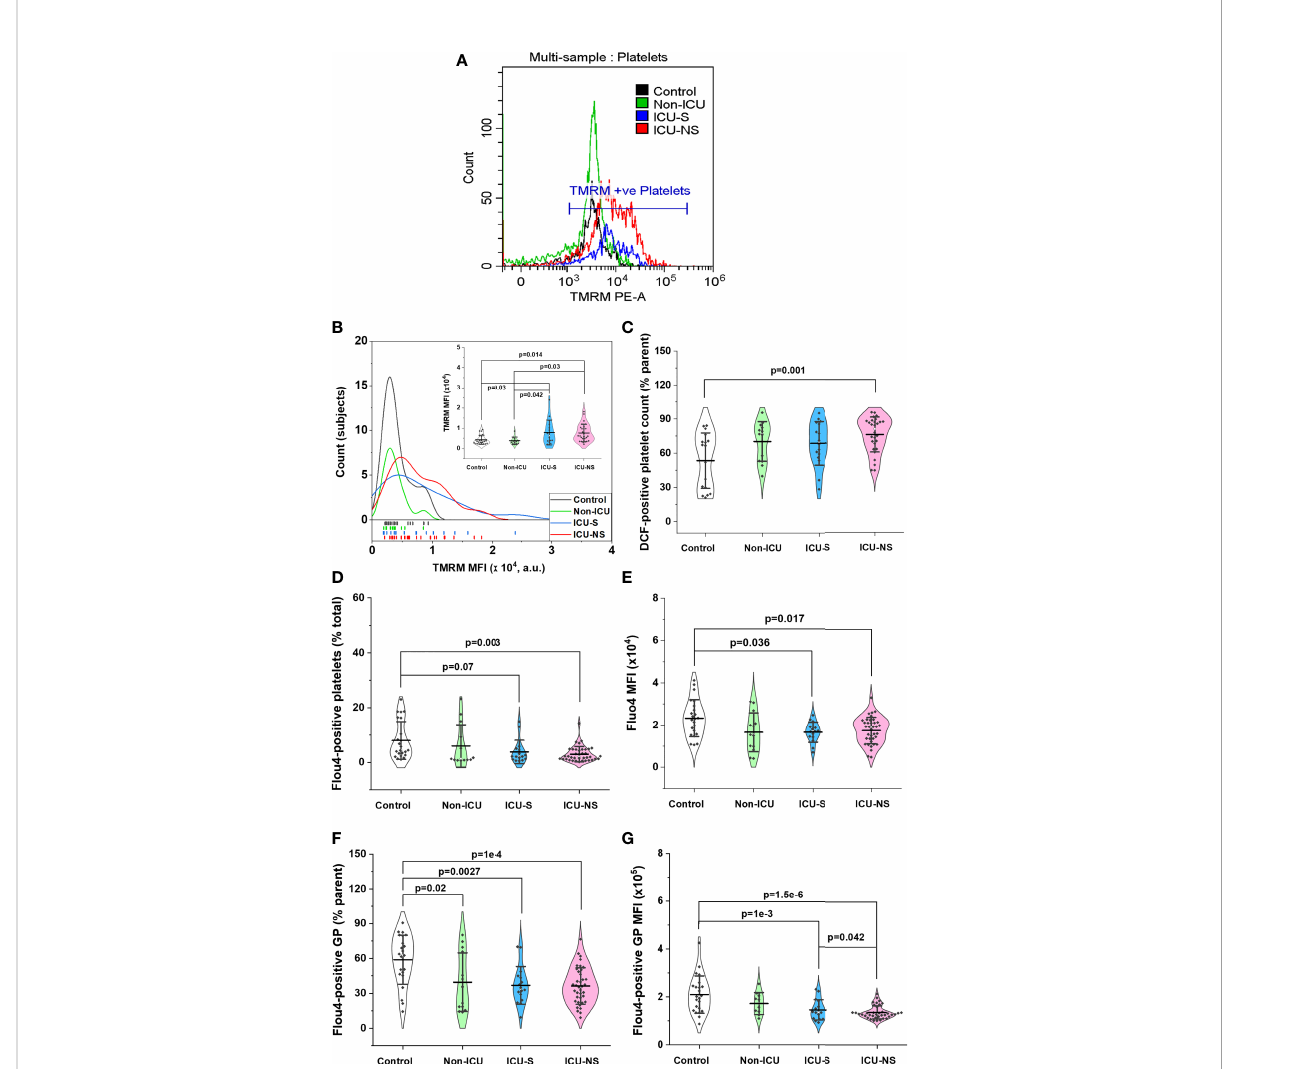
FIGURE 4 Changes in platelets ’ mitochondrial transmembrane potential, ROS levels, and intracellular calcium in relation to severity and mortality outcomes. (A) Representative fl ow cytometric histograms comparing TMRM fl uorescence for all groups. (B) When the distribution of TMRM mean fl uorescence intensity were compared for all groups, both ICU-S and ICU-NS showed hyperpolarized mitochondria (n=23, 12, 16, and 29 for control, non-ICU, ICU-S, ICU-NS; respectively). DCF staining revealed increased levels of ROS in platelets (% parent) (C) of ICU-NS group (n=17, 13, 16, and 28 for control, non-ICU, ICU-S, ICU-NS; respectively). Quanti fi cation diagrams revealed signi fi cantly decreased counts of calcium-positive platelets (D) , n=23, 13, 16, and 38 for control, non-ICU, ICU-S, ICU-NS; respectively) and intracellular Ca 2+ levels (E) , n=23, 13, 15, and 37 for control, non-ICU, ICU-S, ICU-NS; respectively) in platelets from ICU -hospitalized groups relative to control group. When the counts of calcium-positive giant platelets (F) and intracellular Ca 2+ levels in giant platelets (G) were compared for all groups, ICU -hospitalized groups showed statistically signi fi cant increase in calcium-positive cell count and mean fl uorescence intensity relative to control group (n=23, 13, 16, and 38 for control, non-ICU, ICU-S, ICU-NS; respectively). Multiple comparisons were carried out using ANOVA followed by Tukey test and p values are given. Data plotted as mean ±